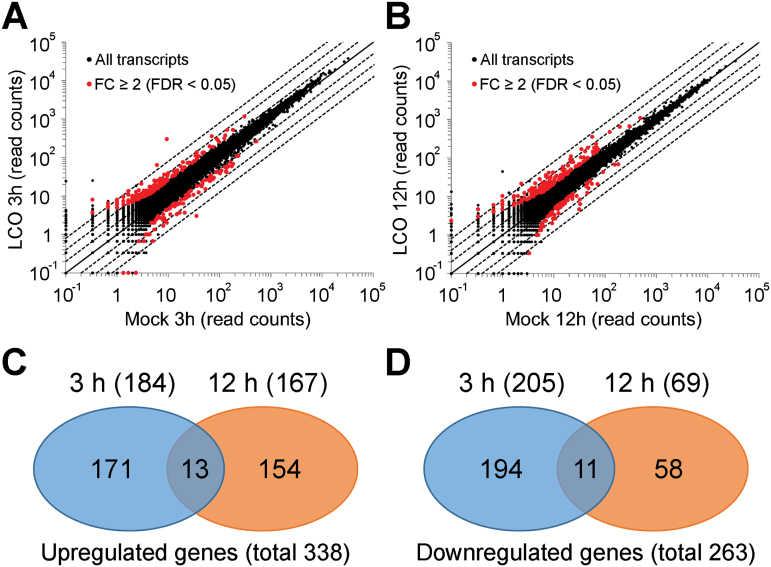
RNA-seq analysis in LCO-treated maize roots. (A, B) Scatter plots showing a comparison of read counts between LCO treatment (y axis) and mock control (x axis) with logarithmic scales. To allow for log adjustment, genes with 0 read counts were assigned a value of 0.1. Red dots show the genes significantly altered after treatment with 10nM LCO (fold change ≥ 2, FDR < 0.05). Black solid lines indicate the same intensity between two treatments, whereas black dash lines (extended obliquely upward and downward) indicate 2-, 4-, and 8-fold changes, respectively. The data were based on three replicates for each treatment. (C, D) The Venn diagram represents the overlap in differentially expressing genes between different time points. FC; fold change.